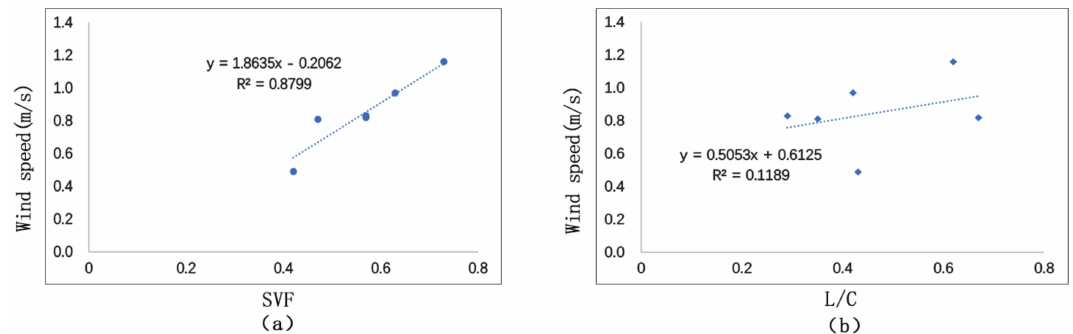
Figure 21. Correlation between SVF, L / C and wind speed: ( a ) correlation between SVF and wind speed; ( b ) correlation between L / C and wind speed.